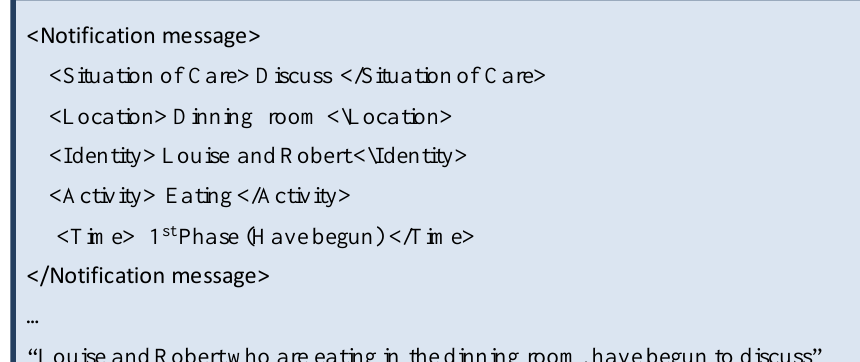
Figure 12. An example of an XML notification message.